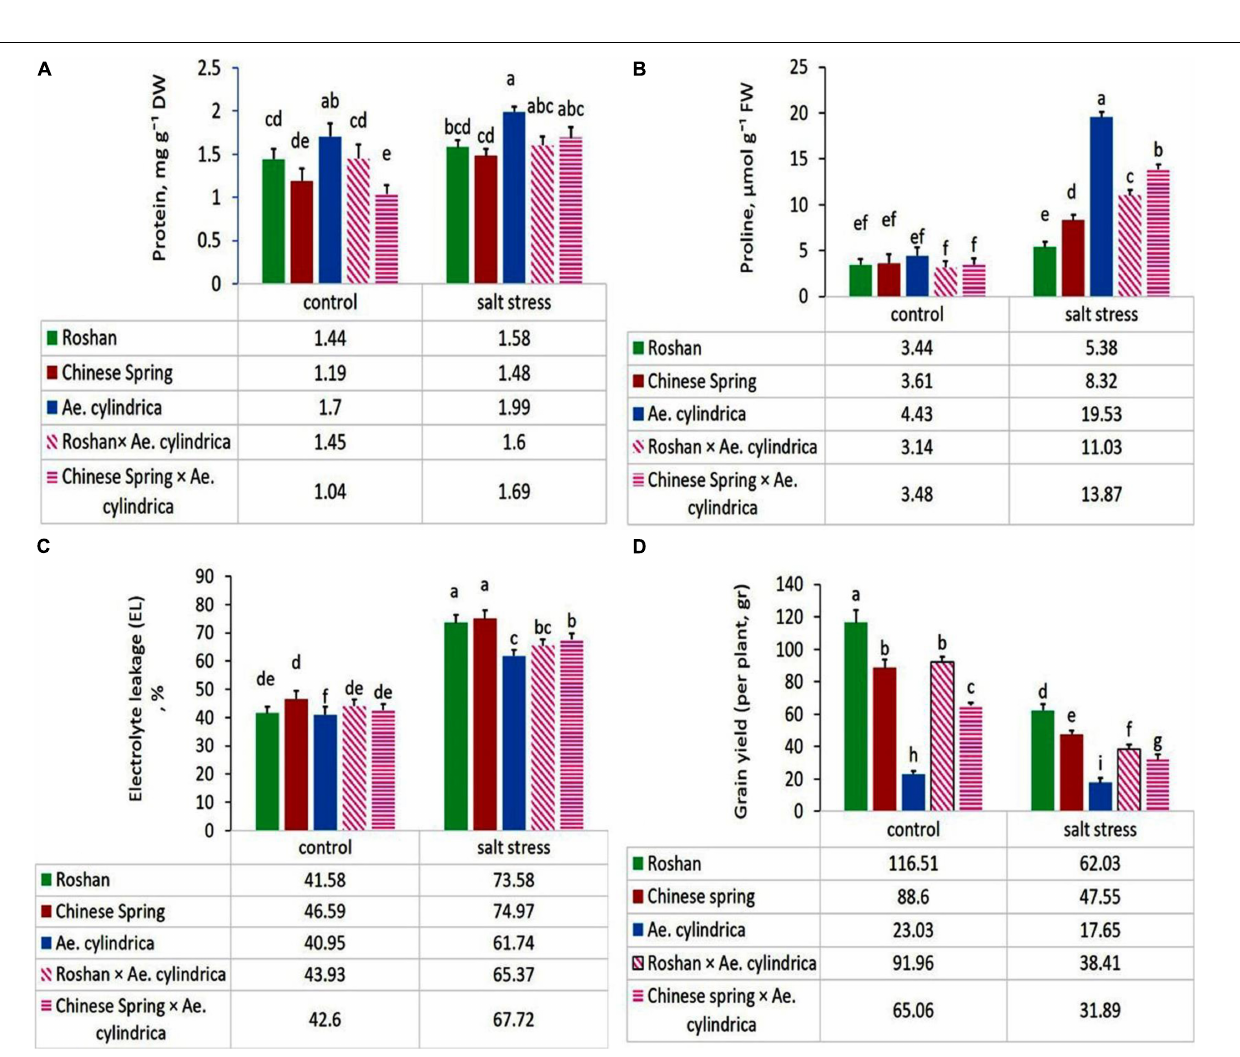
FIGURE 1 | Mean comparison of (A) total protein content, (B) proline content, (C) electrolyte leakage, and (D) grain yield of parents ( T. aestivum “Roshan,” “Chinese spring,” Ae. cylindrica ) and their F 1 hybrid plants (amphidiploids) under control and salt stress conditions. Bars represent means ± SE and bars with the same letter do not significantly differ at P < 0.05 among the